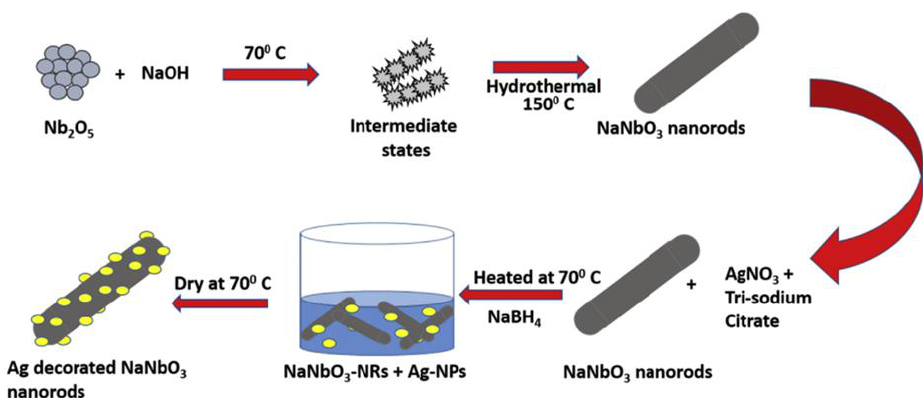
Figure 5. Schematic representation of the different steps involved in the formation of perovskite particles from the hydrothermal method and Ag decoration pervoskite surface by the chemical solution. Reprinted with permission from Kumar, D.; Singh, S.; Khare, N. Plasmonic Ag nanoparticles